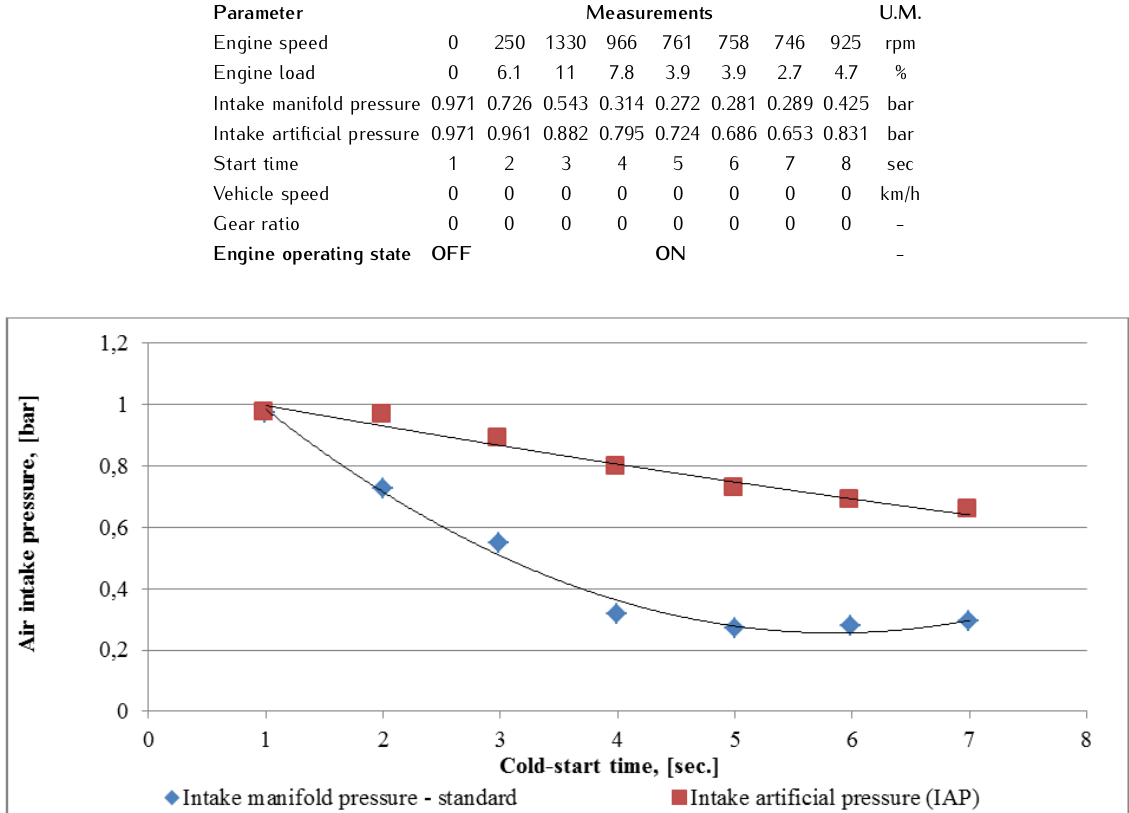
Figure 4. Air intake pressure in the engine manifold (with and without artificial intervention) at cold-start conditions.